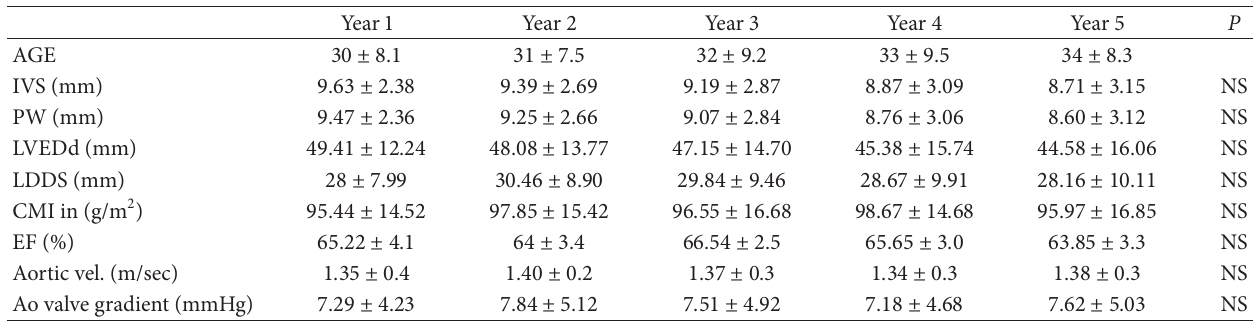
Table 4: BAV sedentary: details of echocardiographic parameters during the 5-year followup.